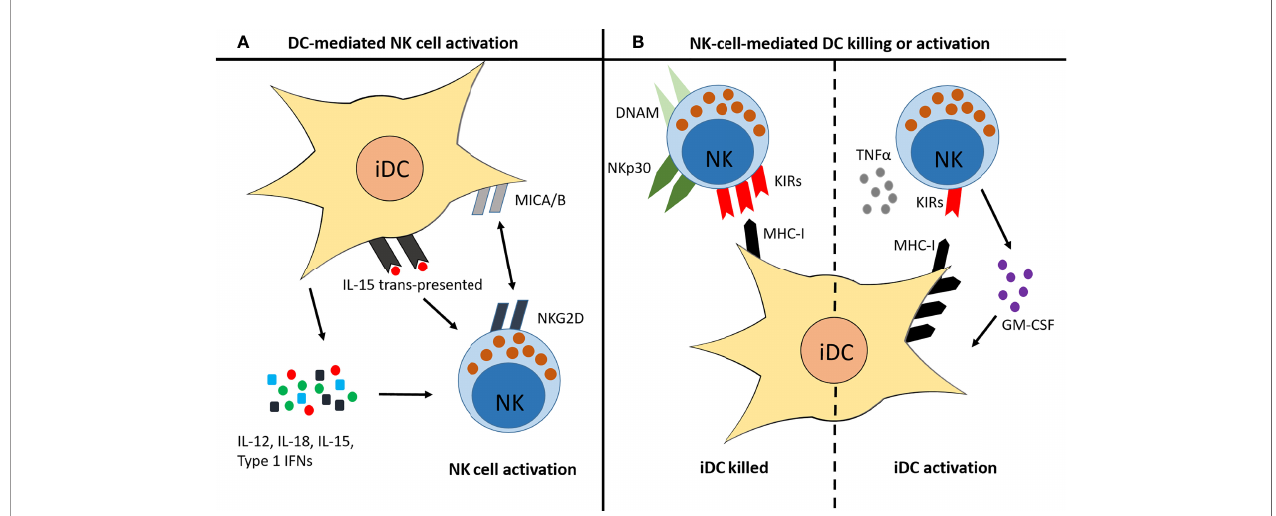
FIGURE 5 | Reciprocal interactions between NK cells and immature DCs. (A) iDCs can promote NK cell activation and maturation in several ways: they secrete IL- 12, IL-18, IL-15 and type I IFNs; they trans-present IL-15 to NK cells; and they express MICA/B, which binds to NKG2D on the surface of NK cells. (B) Once activated, NK cells then promote either killing of the iDC or activation of the iDC, depending on various factors. iDC killing is usually induced when the NK cell expresses high levels of NKp30 and DNAM, and/or when the iDC expresses low levels of MHC-I. iDC activation is induced when high levels of TNF a are